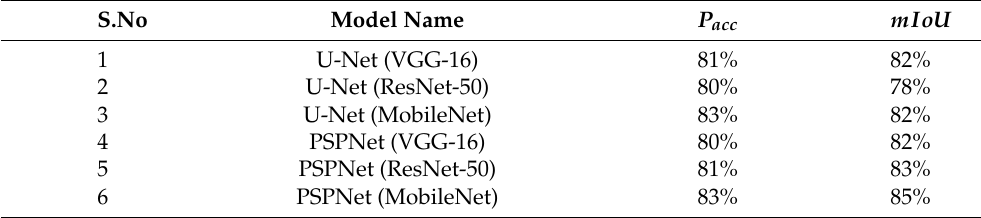
Table 1. Comparison results P acc and mIoU of PSPNet and Un-Net with different base architectures. S.No Model Name P acc